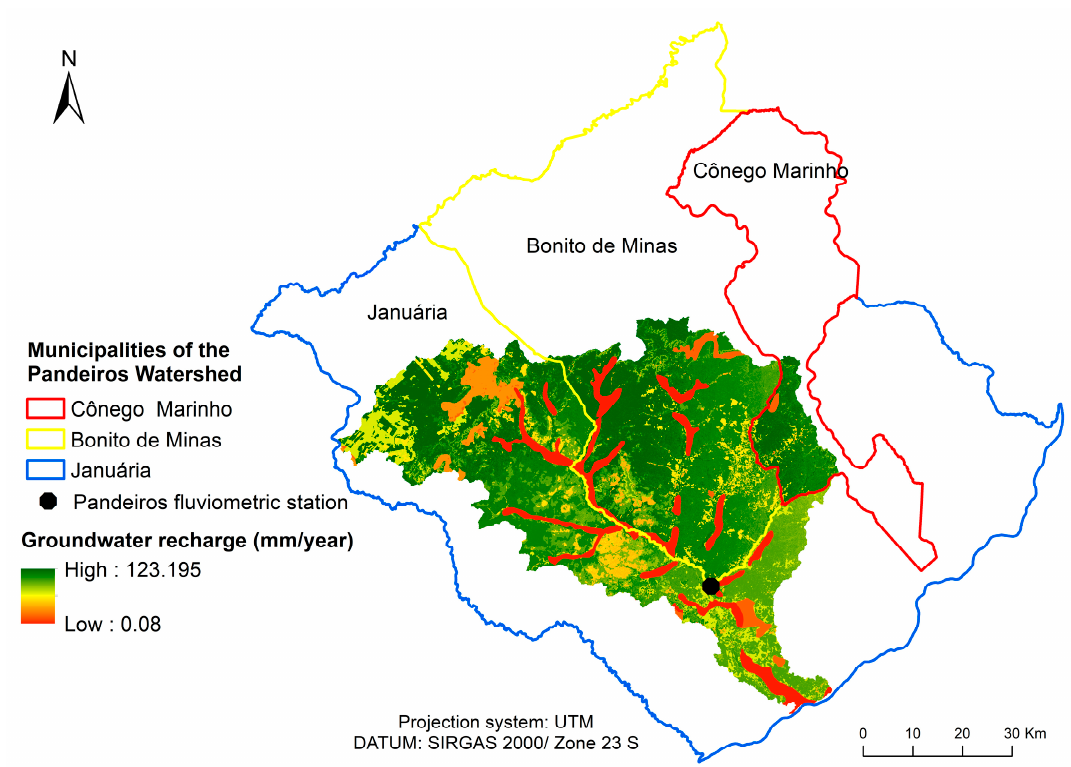
Figure 13. Spatial distribution of groundwater recharge potential in the municipalities of Pandeiros River